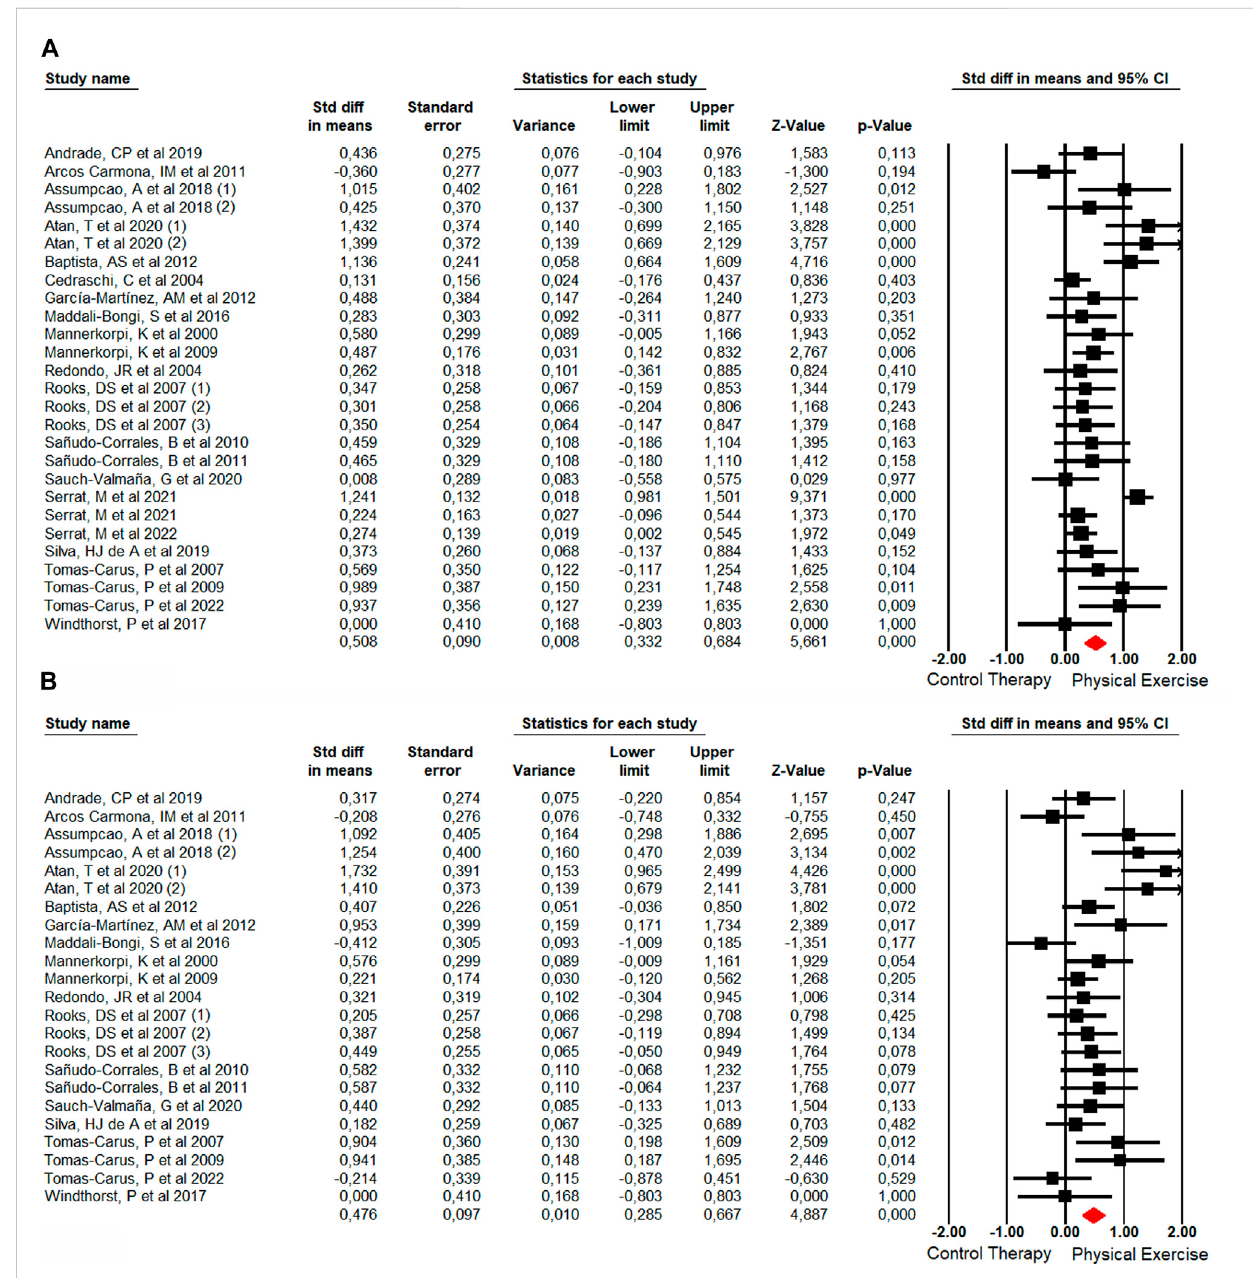
FIGURE 4 Forest Plot of the immediate effect of PEBT on QoL-physical (A) and mental dimension (B) .